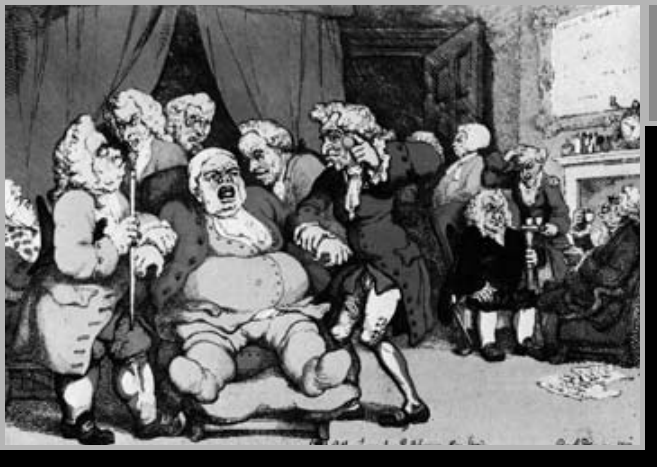
integrado às questões e aos relatos sociais brasileiros. Da mesma maneira que atendia à corte, produzindo gravuras que retratavam o cerimonial cotidiano dos nobres e atendendo pessoalmente a D. Pedro I, sentia-se intimamente ligado à vida da cidade, com seus escravos e senhores, hábitos, costumes e tradições. Em aquarelas, gravuras e litogravuras, Debret foi precioso na descrição visual da vida urbana do Brasil do início do século XIX, revelando – sem pudor, mas sem exageros – a realidade da escravidão, os castigos aos negros trazidos da África, a miscigenação que se iniciava e até mesmo a dificuldade experimentada pelos negros já